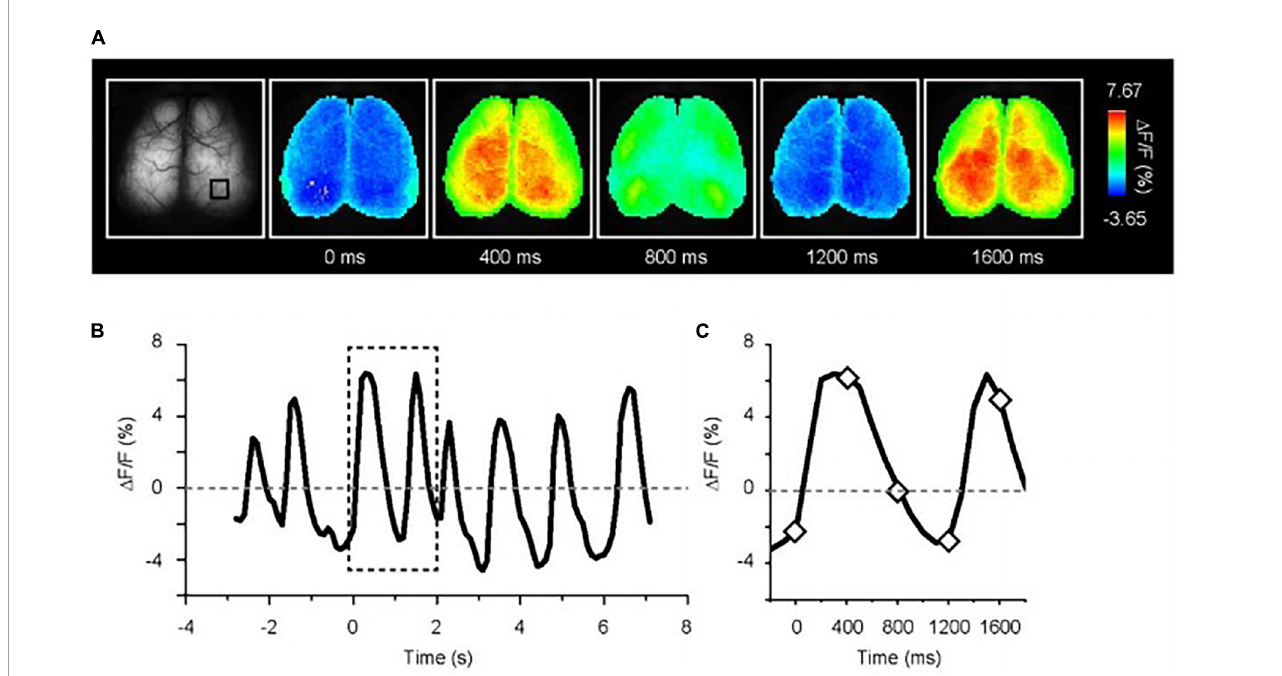
FIGURE3 Spontaneous Ca 2 + oscillation in deeply anesthetized G7NG817 mouse. (A) Representative images of Ca 2 + oscillations. Pseudocolor is superimposed on the raw brain images. (B) Example trace of fluorescence change ratio in the black square drawn in (A) . The baseline is the mean of all-time course. The sampling rate is 10 Hz. (C) Magnified trace in the dotted line in (B) . The diamonds correspond to the time point shown in (A) [Modified from Monai et al. (2016)].